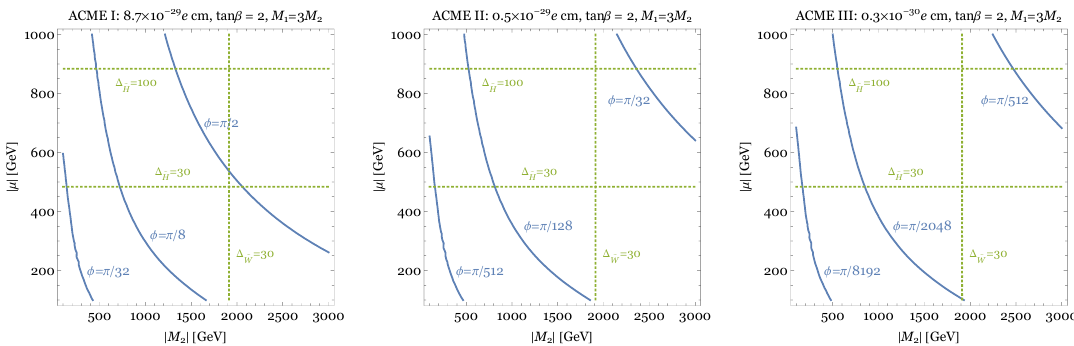
Figure 12 . A closer look at the low mass region: constraints on the chargino phase (cid:30) = arg( M 2 (cid:22)b (cid:3) as a function of the chargino mass parameters, with the current ACME electron constraint (left) and two future projections. Regions below and to the left of the blue curves are excluded. Again, we have superimposed dotted green contours of electroweak (cid:12)ne tuning associated with large higgsino or wino